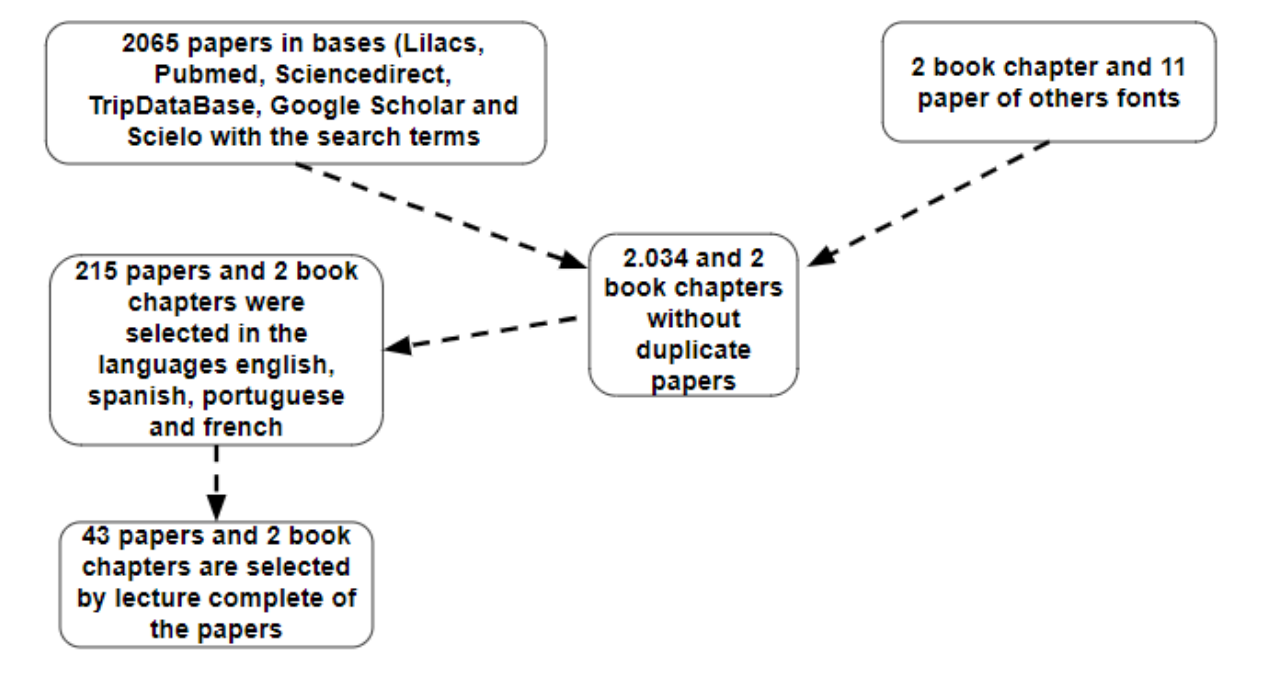
Figure 1. Flowchart of the literature systematic review